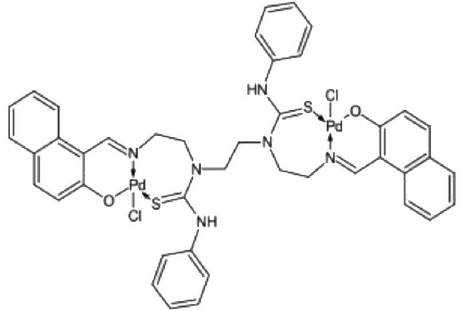
Figure 7 Tridentally coordinated bis-[1-(2-[(2-hydroxy-